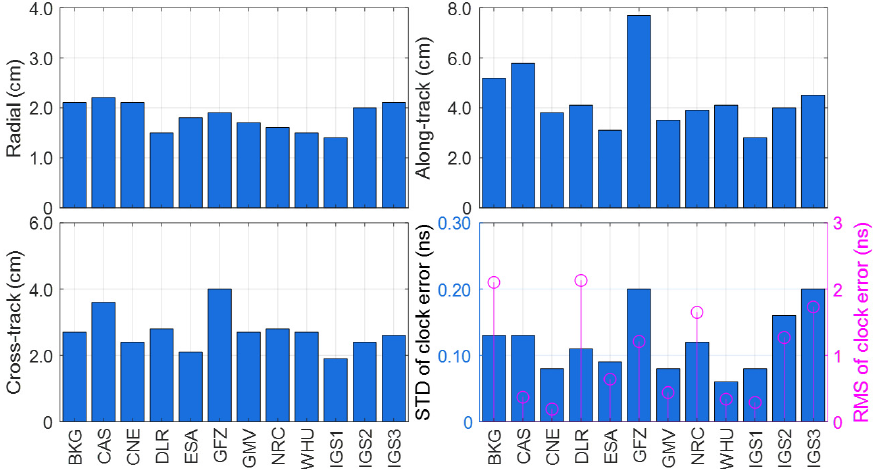
Figure 3. The accuracy of GPS SSR products. The STD (Left y axis and blue) and RMS (Right y axis and magenta) of clock errors is presented in the lower-right subplot.